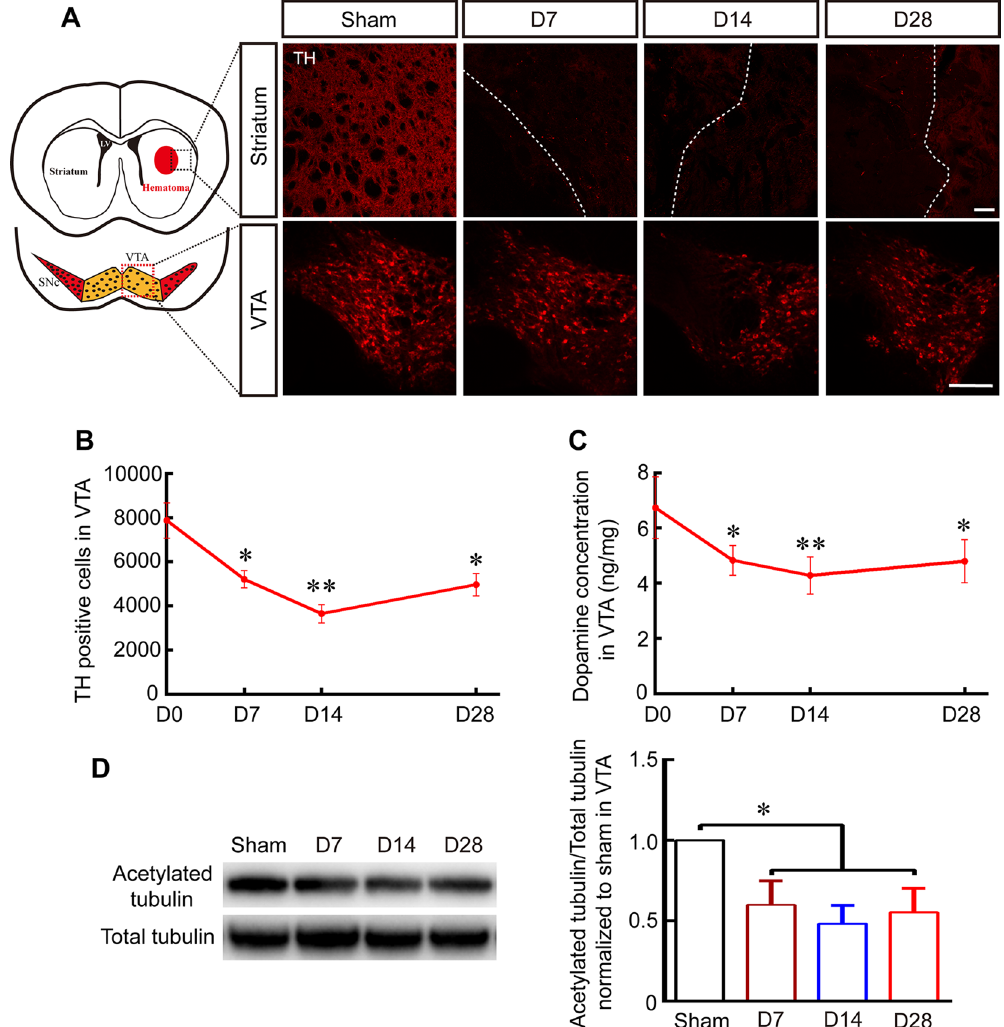
Figure 2. ICH-induced MT depolymerization contributed to impairments in DA neurons’ numbers and DA concentrations. ( A ) Representative pictures of TH-labelled DA fibers and neurons in the striatum and VTA in the sham group and at 7, 14, and 28 days post-ICH (Scale bar: 100 µ m; red dotted grid indicates the observation area, and white dotted lines distinguish the hematoma area and the surrounding unaffected tissues). ( B ) The number of TH-positive cells in the VTA was evaluated in a stereological analysis at 7, 14, and 28 days post- ICH and in the sham group (replaced by 0 day). ( C ) The dopamine concentration was measured in VTA using HPLC-ECD at 7, 14, and 28 days after ICH and in the sham group (replaced by 0 day). ( D ) Representative Western blot images and quantitative data for acetylated α -tubulin and total tubulin expression in the VTA at 7, 14, and 28 days post-ICH and in the sham group (Full-length blots/gels are presented in Supplementary Figure S1). Data are shown as the means ± SEM (at least n = 5 for each group; * P < 0.05 and ** P < 0.01 versus sham group). SNc = substantia nigra pars compacta; LV = lateral ventricle; TH = tyrosine